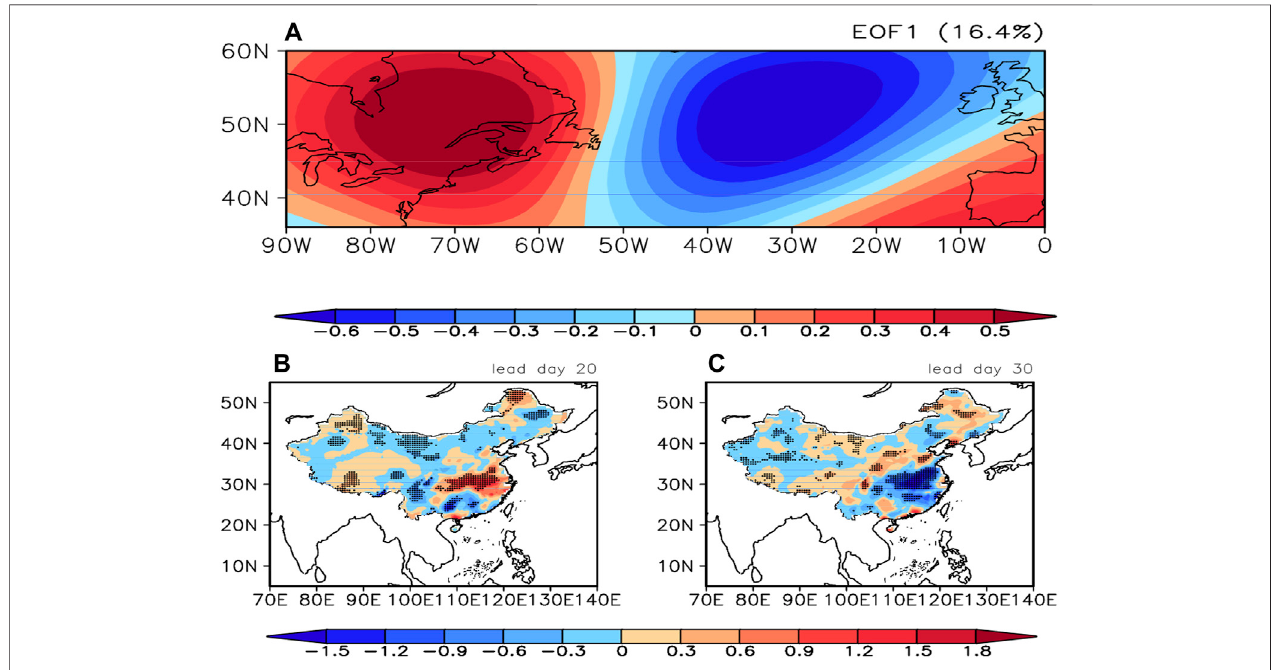
FIGURE 8 | First mode [EOF1, (A) ] of the EOF analysis of 10 – 30-day fi ltered geopotential height at 500hPa over the North Atlantic Ocean and the composition of quasi-biweekly precipitation (unit: mm/d) based on the geopotential height QBWO events with 20-day lag (B) and 30-day lag (C) .